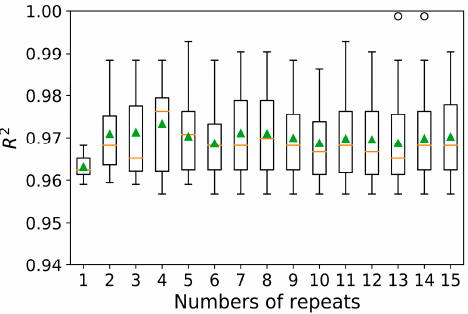
Figure 7. Plots of R 2 vs. repeats for 10-fold cross-validation.